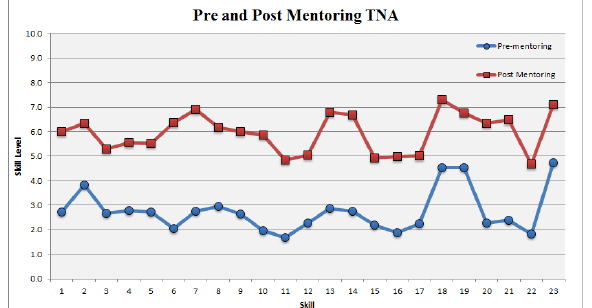
Figure 4. Self-evaluation of knowledge and skills in remote sensing and GIS before and after the training and mentoring